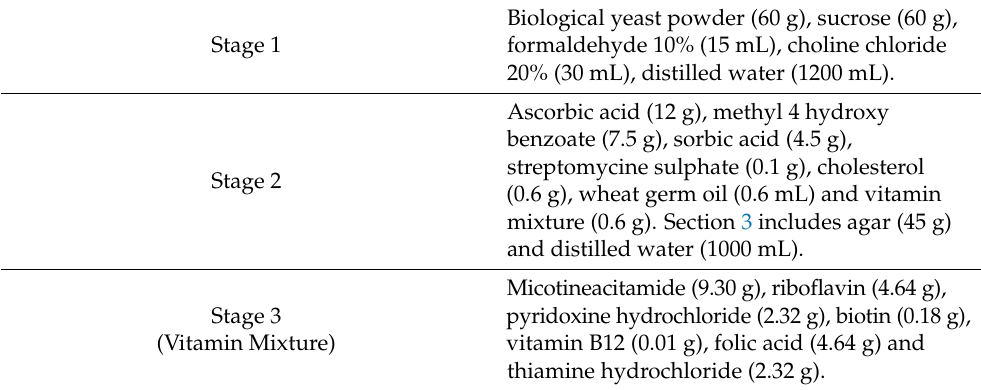
Table 1. Artificial substrate of laboratory culture of H. armigera (Adapted with permission from Ref.